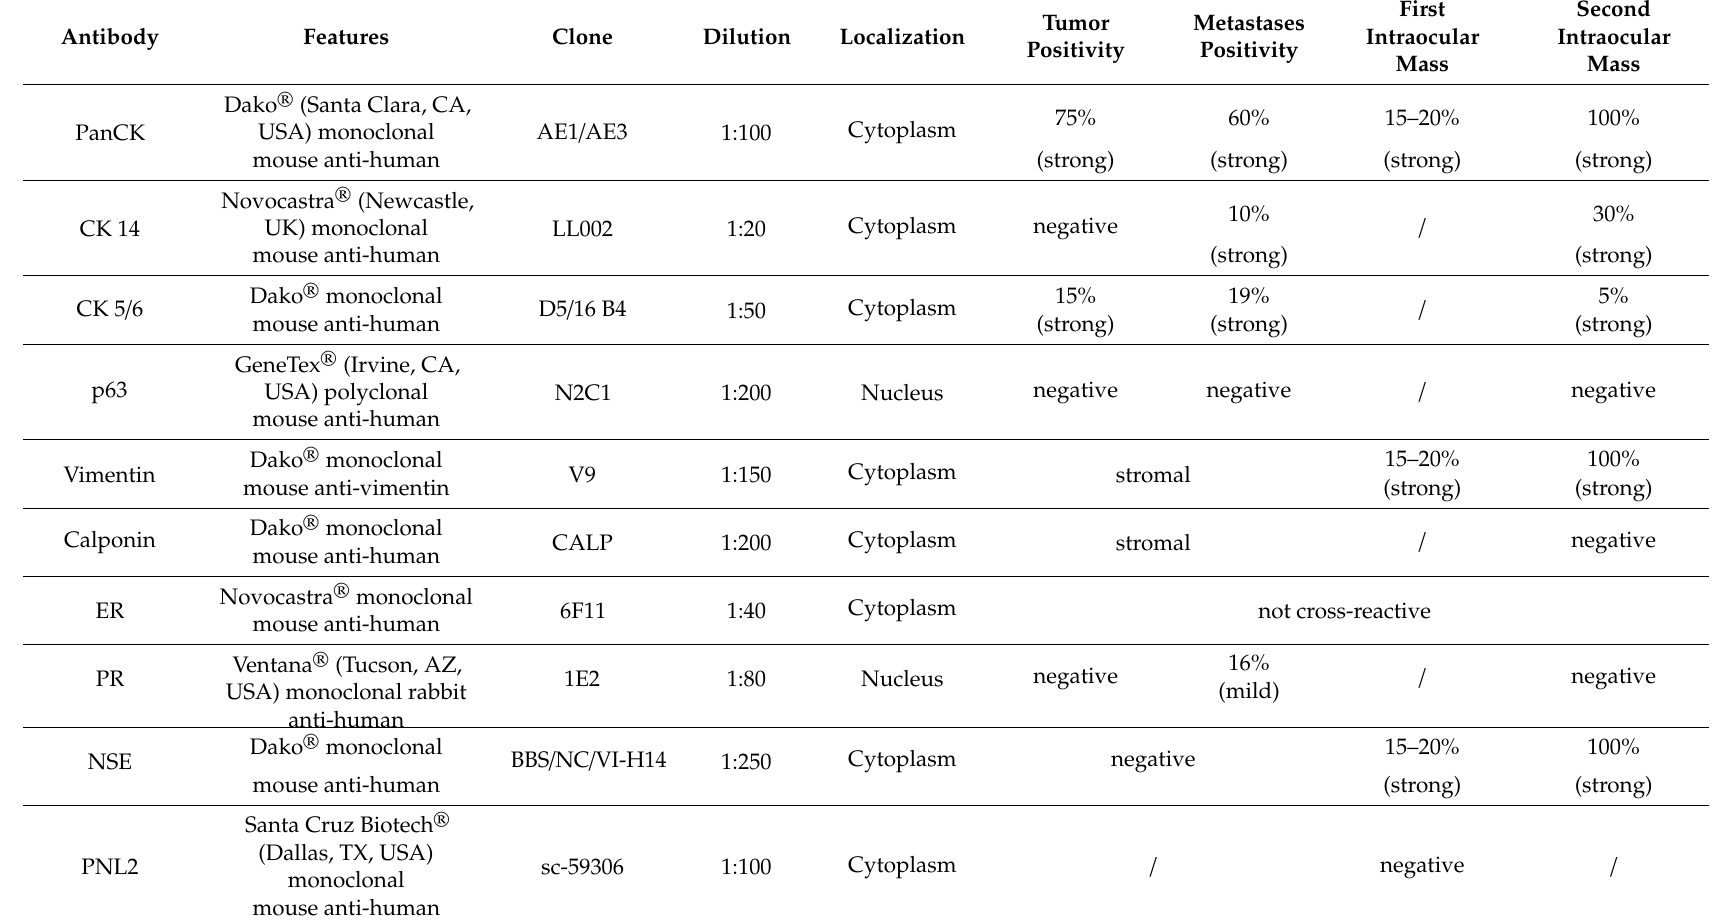
Table 1. List of antibodies applied in the present